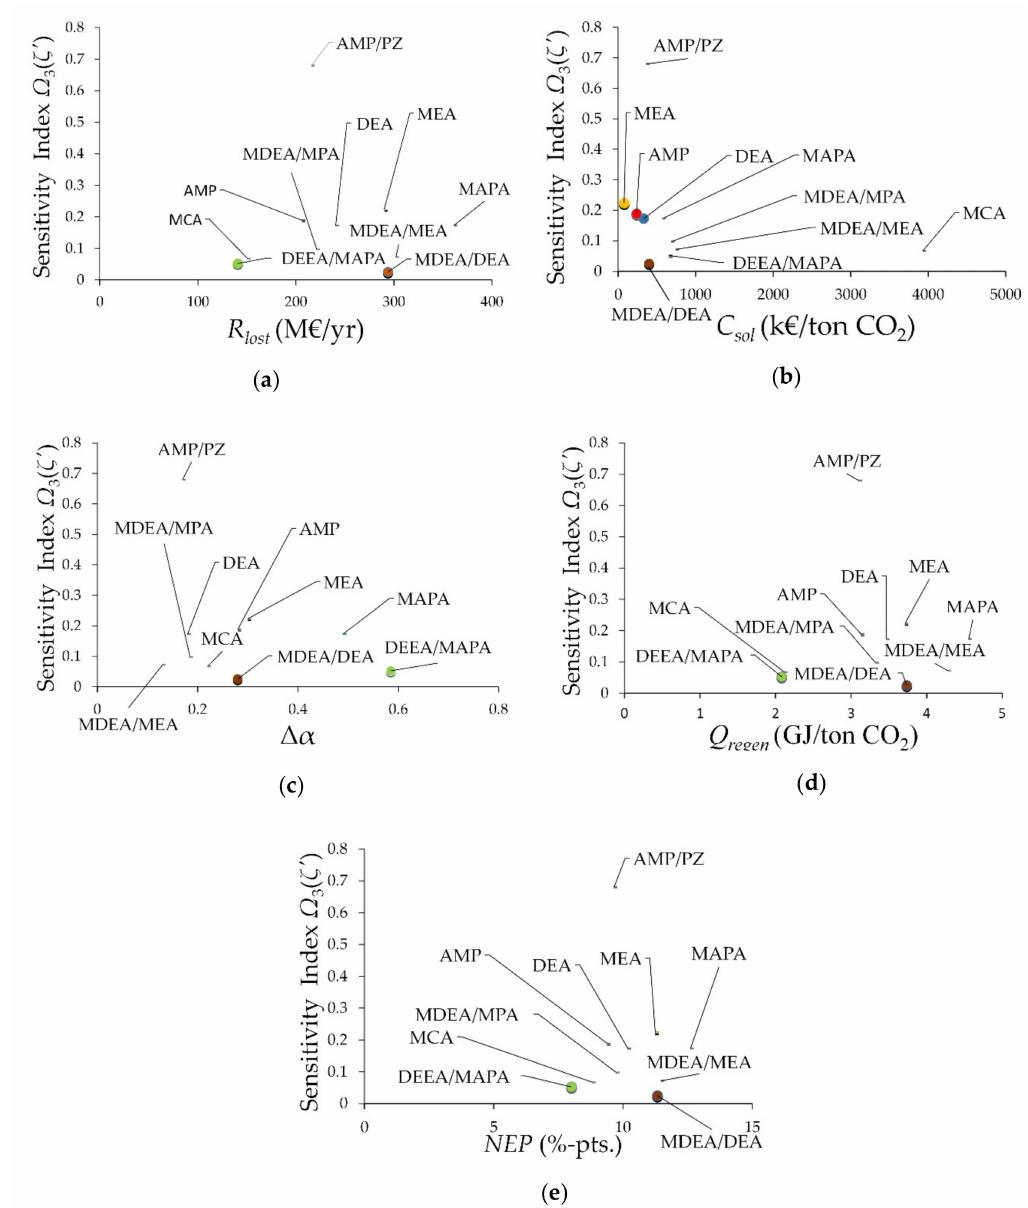
Figure 7. Pareto front between the sensitivity index Ω 3 ( ζ (cid:48) = − 0.15 ) and ( a ) R lost , ( b ) C sol , ( c ) ∆ α , ( d ) Q regen , and ( e ) NEP . Marks other than colored circles indicate undesirable